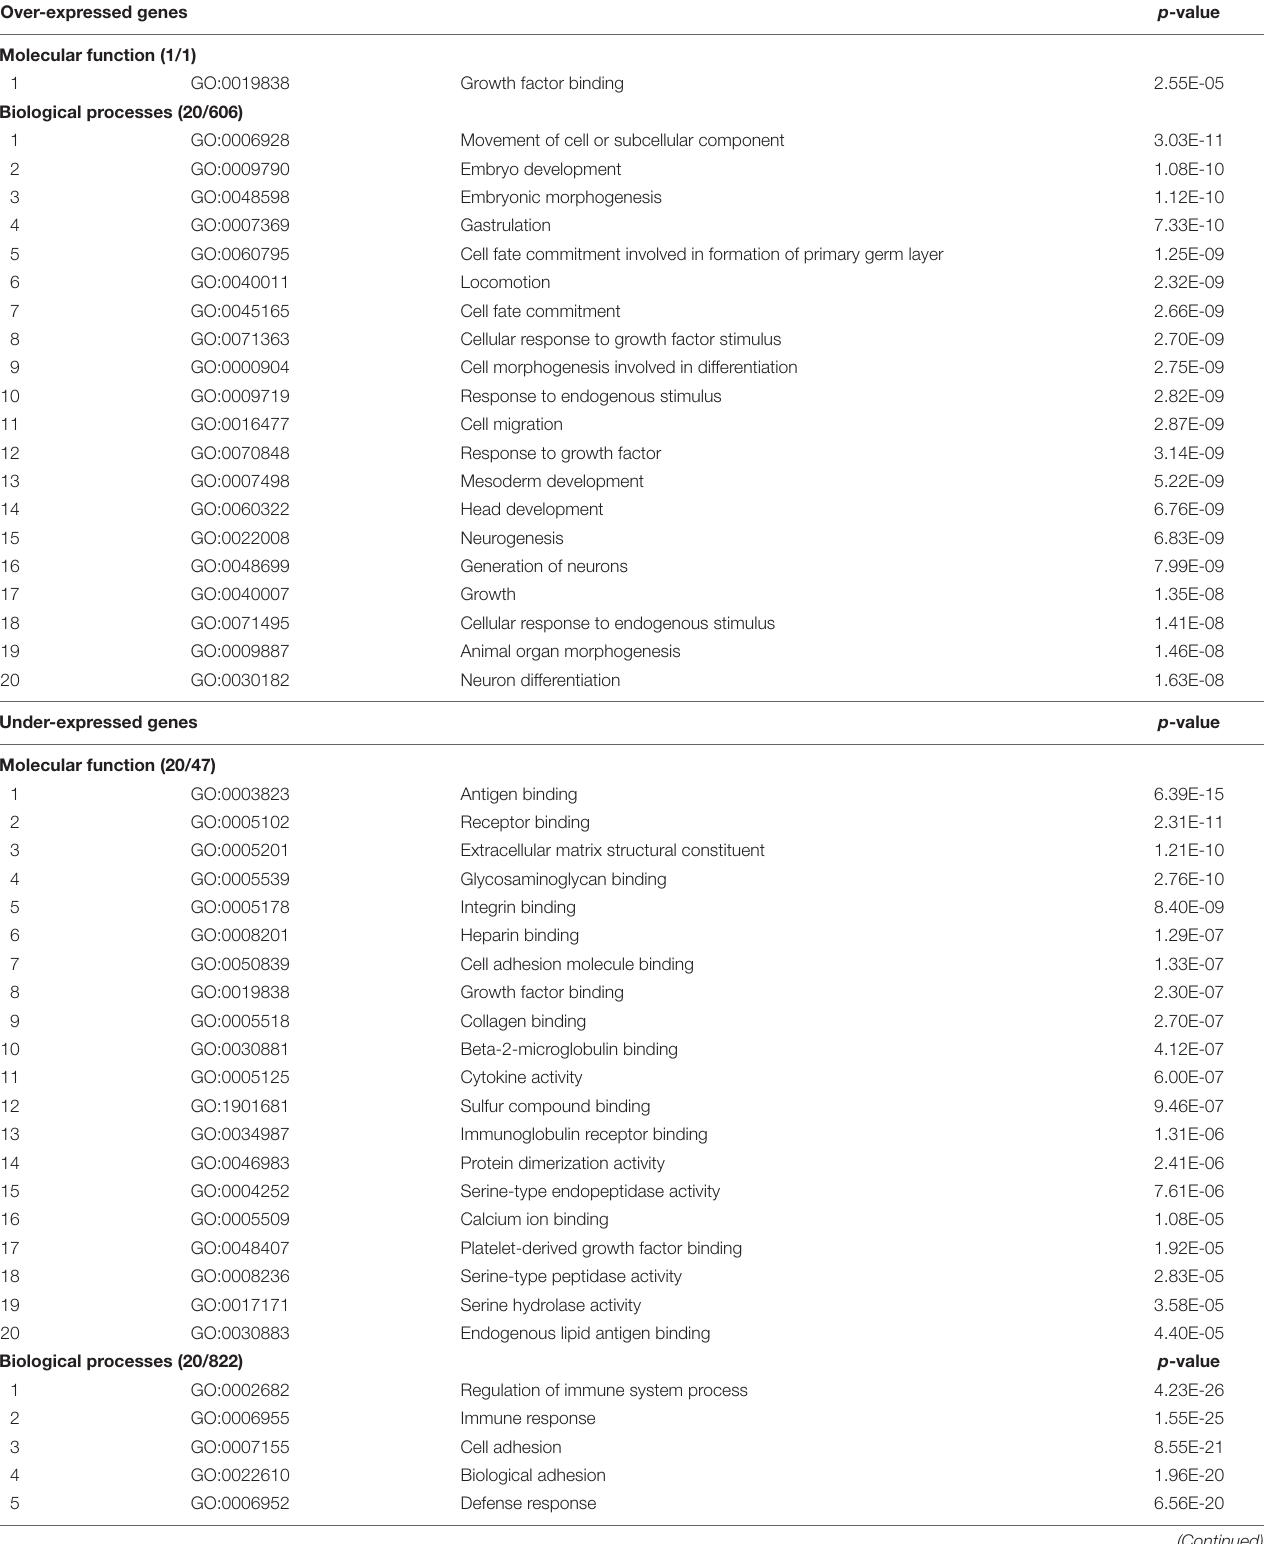
TABLE 2 | Results of functional enrichment analysis, performed by ‘ToppFun’ from the ‘ToppGene Suite’ Gene Ontology tool, of over- and under-expressed genes (with expression ratios ≥ 1.30 and ≤ 0.76, respectively) in the “Total transcriptome map”. Over-expressed genes p